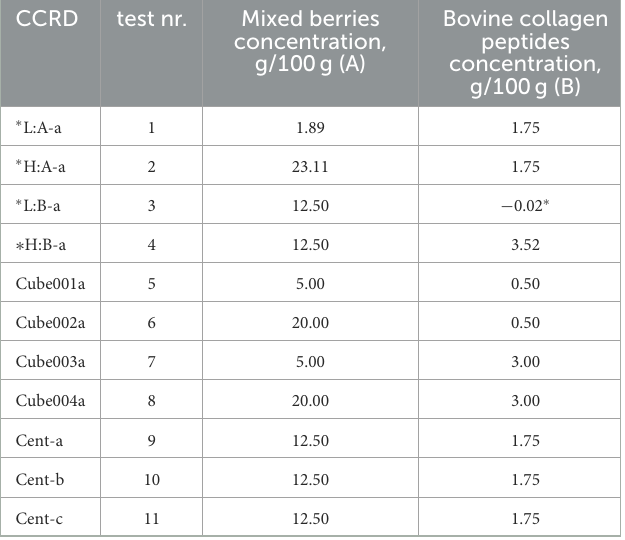
TABLE 2 The calculated concentrations of mixed berries and bovine collagen peptides according to the central composite rotational design (CCRD) ( ∗ is a theoretically calculated value, 0/100g bovine collagen peptides were added). CCRD test nr.